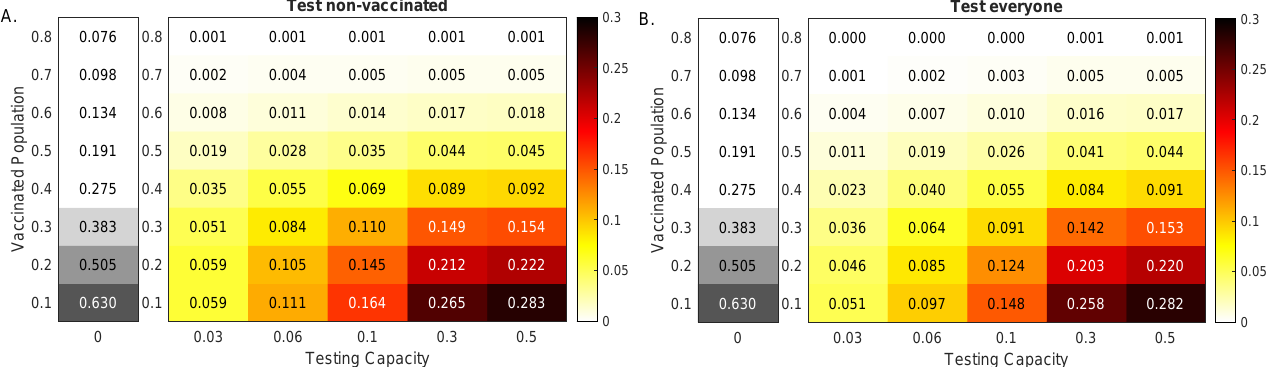
Figure 4. Reduction in Alpha variant cases at 100 days. Heatmaps for the reduction in cumulative cases at 100 days after an outbreak with an Alpha variant, Σ noTests ( 100 ) − Σ Tests ( 100 ) , as given by model Equation (1) versus RT-PCR testing capacity with a return delay of 1 day, C , and background vaccination levels, V 0 . Panel ( A ): Test non-vaccinated only; Panel ( B ): Test everybody. The gray heatmaps represent the cumulative cases at day 100 in the absence of testing, Σ noTest ( 100 ) . Parameters and initial conditions are given in Table